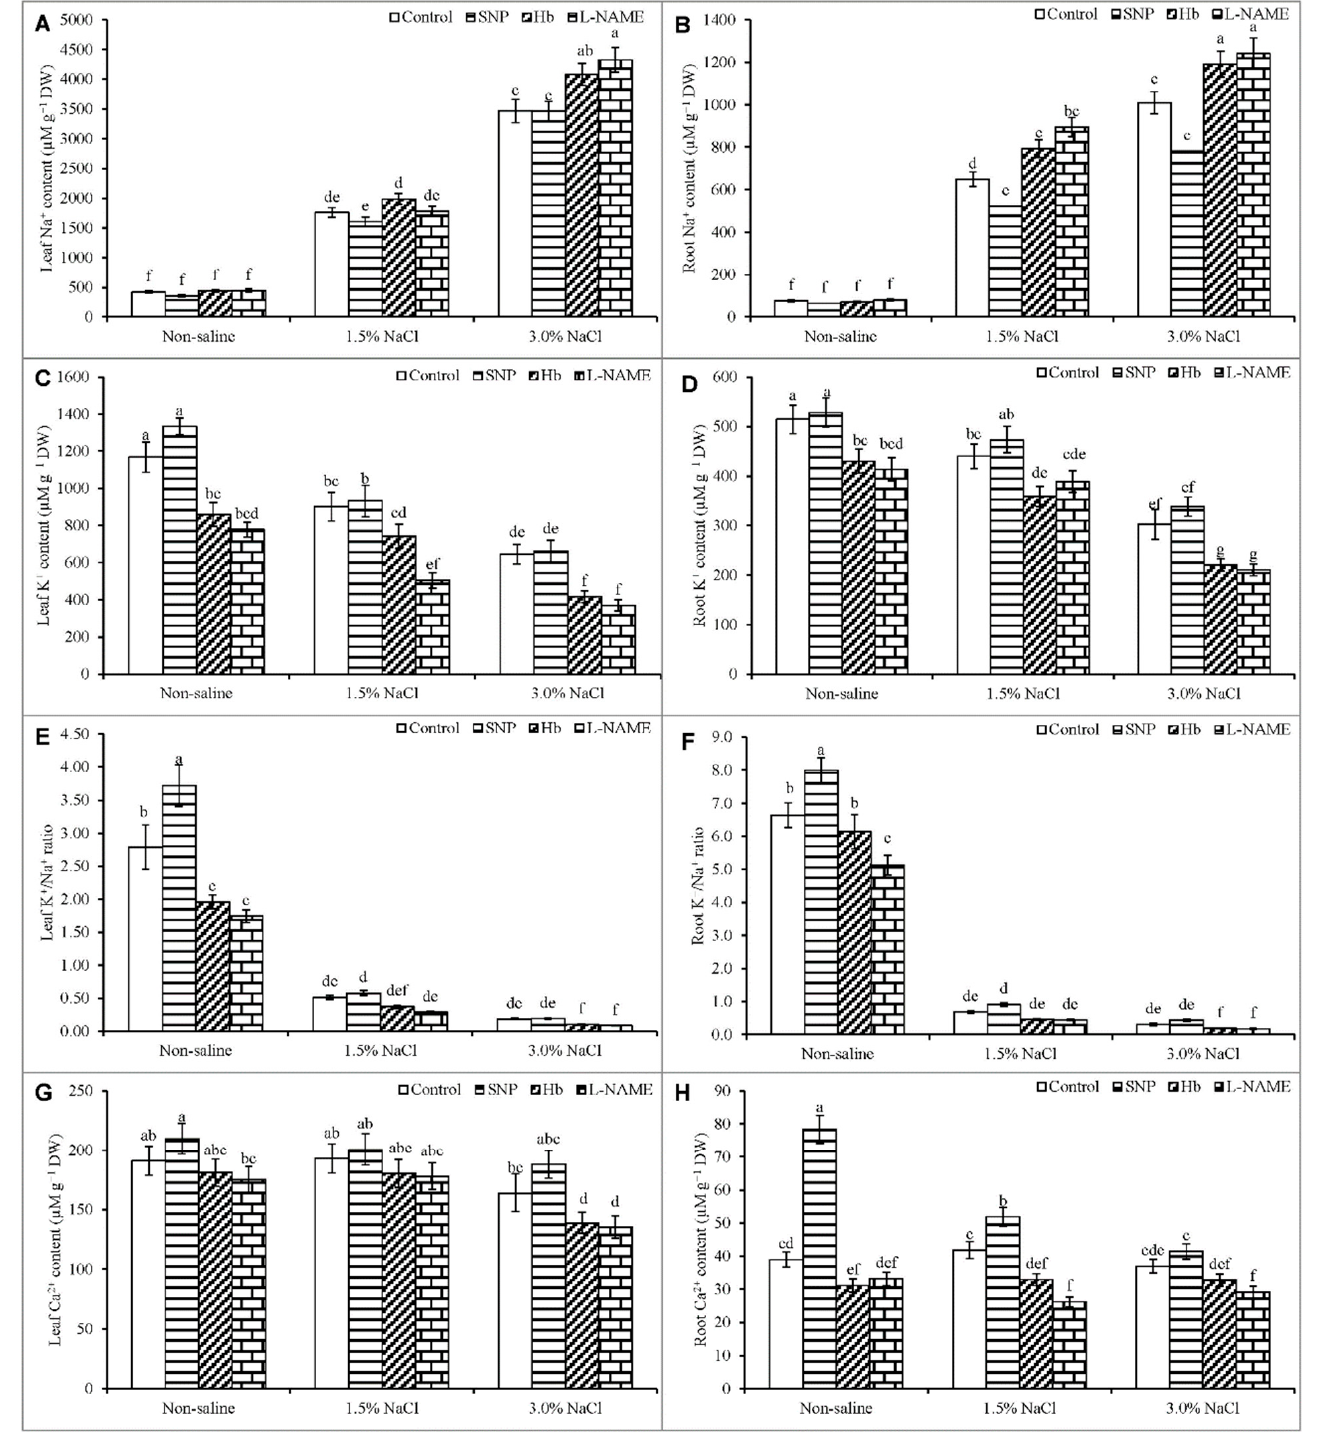
Figure 9. Na + ( A , B ), K + ( C , D ), K + /Na + ratio ( E , F ) and Ca 2+ content in roots ( G ) and leaves ( H ) of Kandelia obovata treated with different salt concentrations and with 100 µM sodium nitroprusside (SNP, a NO donor), hemoglobin (Hb, a NO scavenger), or N ω -nitro- L -arginine methyl ester ( L -NAME, a NO synthase inhibitor). Mean (± SD) was calculated from three replicates for each treatment. Bars with different letters are significantly different at p ≤ 0.05, applying Tukey’s HSD test.